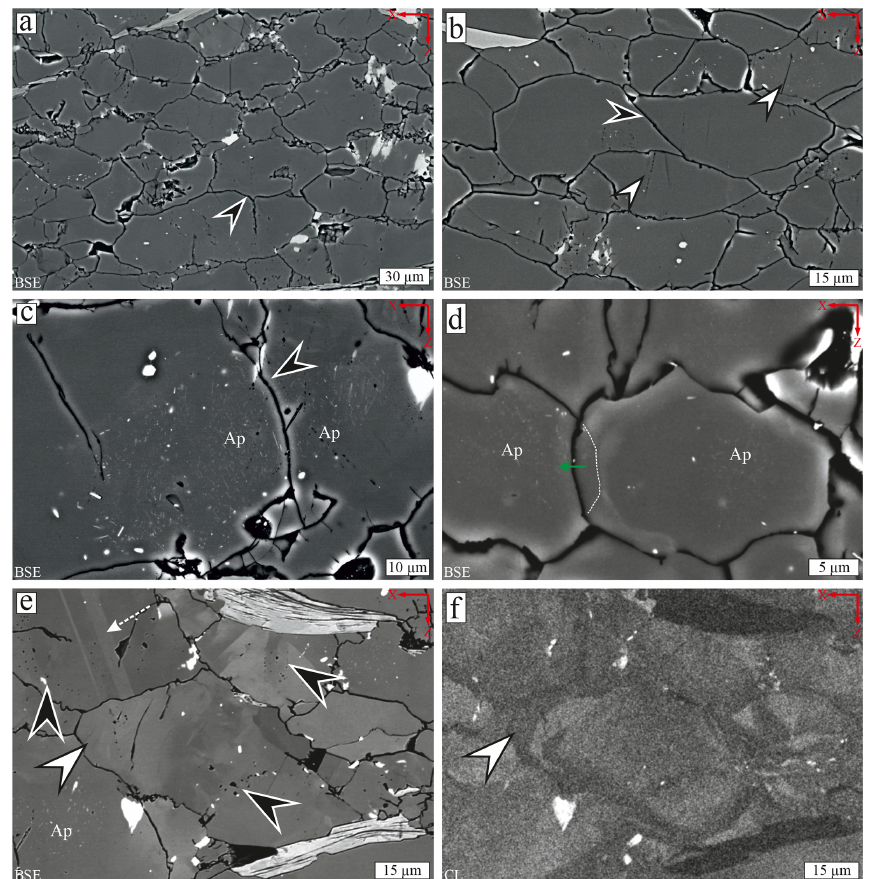
Figure 13. BSE images of albite grains in type B matrix. (a) Overview showing elongated albite grains and some relict Kfs grains (light grey). Note grain boundary affected by a crack in the grain below (arrow). (b) Boundaries can be remarkably straight, especially at a low angle to the foliation (black arrow). Healed microcracks at a high angle to the stretching lineation are indicated by increased porosity (white arrows). (c) Apatite needles in albite grains. Apatite-rich zone is crosscut by grain boundary (arrow). (d) Albite grains showing the Ca-enriched zone, representing the growth rim (green arrow represents growth direction), with the former grain boundary preserved by the zonation (dashed line). (e) Grain with twins (dashed arrow). Black arrows point to porosity, which is associated with zonation (white arrow), best seen in the CL image (f) . The zonation is probably due to changing contents of trace elements, which cannot be resolved in the BSE image.